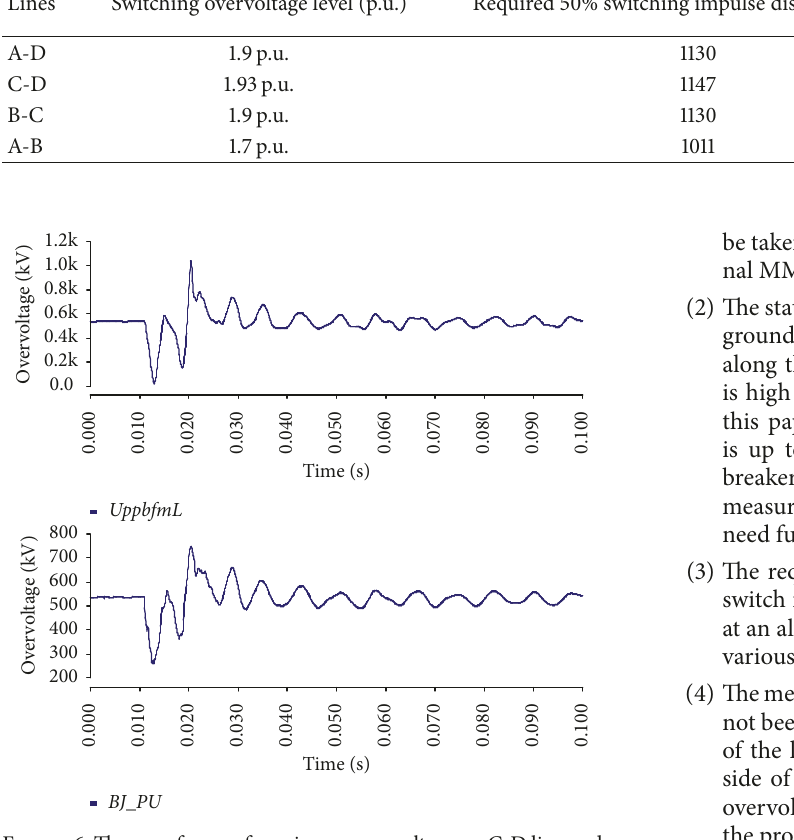
Figure 6: The waveforms of maximum overvoltage on C-D line and pole bus of D station under the mode of unconnected C